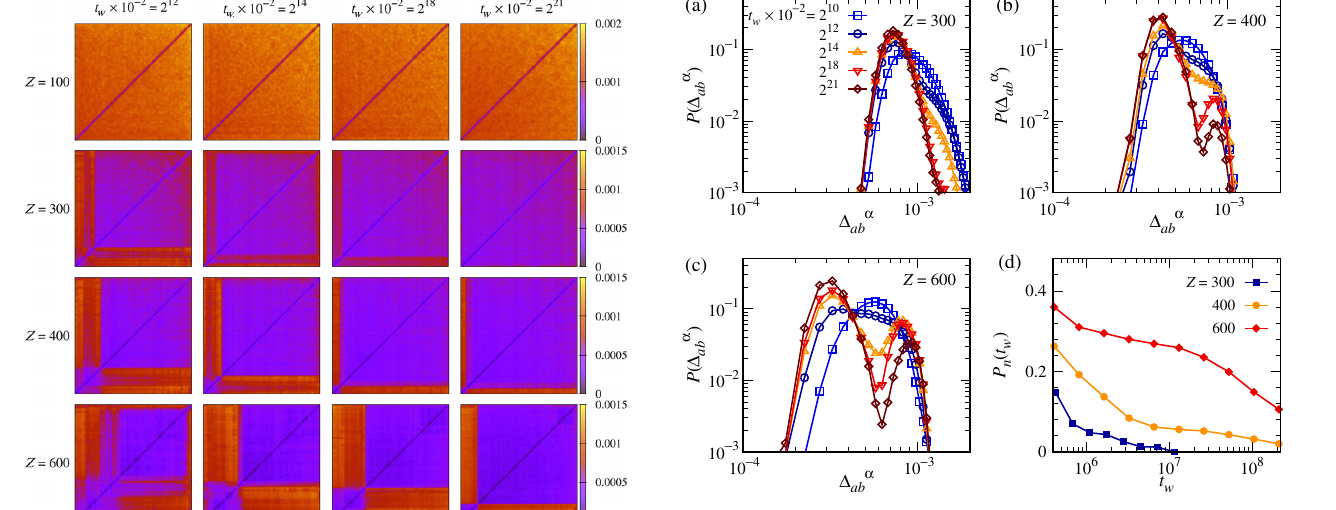
FIG. 8. (a) – (c) Time evolution of the probability distribution Þ for a single sample α with N ¼ 1024 and various ð t Þ for P ð Δ α ab w ab ¼ 1000 clones. (d) The time ¼ 100 clones. The pressures, measured with N c c evolution of the fraction of clones belonging to the less stable group for different pressures resembles the dynamic data in are n G Fig. w